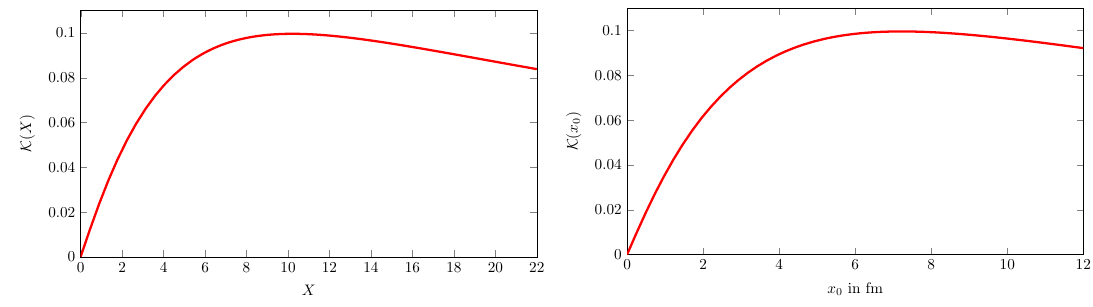
Figure 1 . Plots of the kernel K ( X ) in eq. (3.8) versus X and versus x 0 in Fermi units.